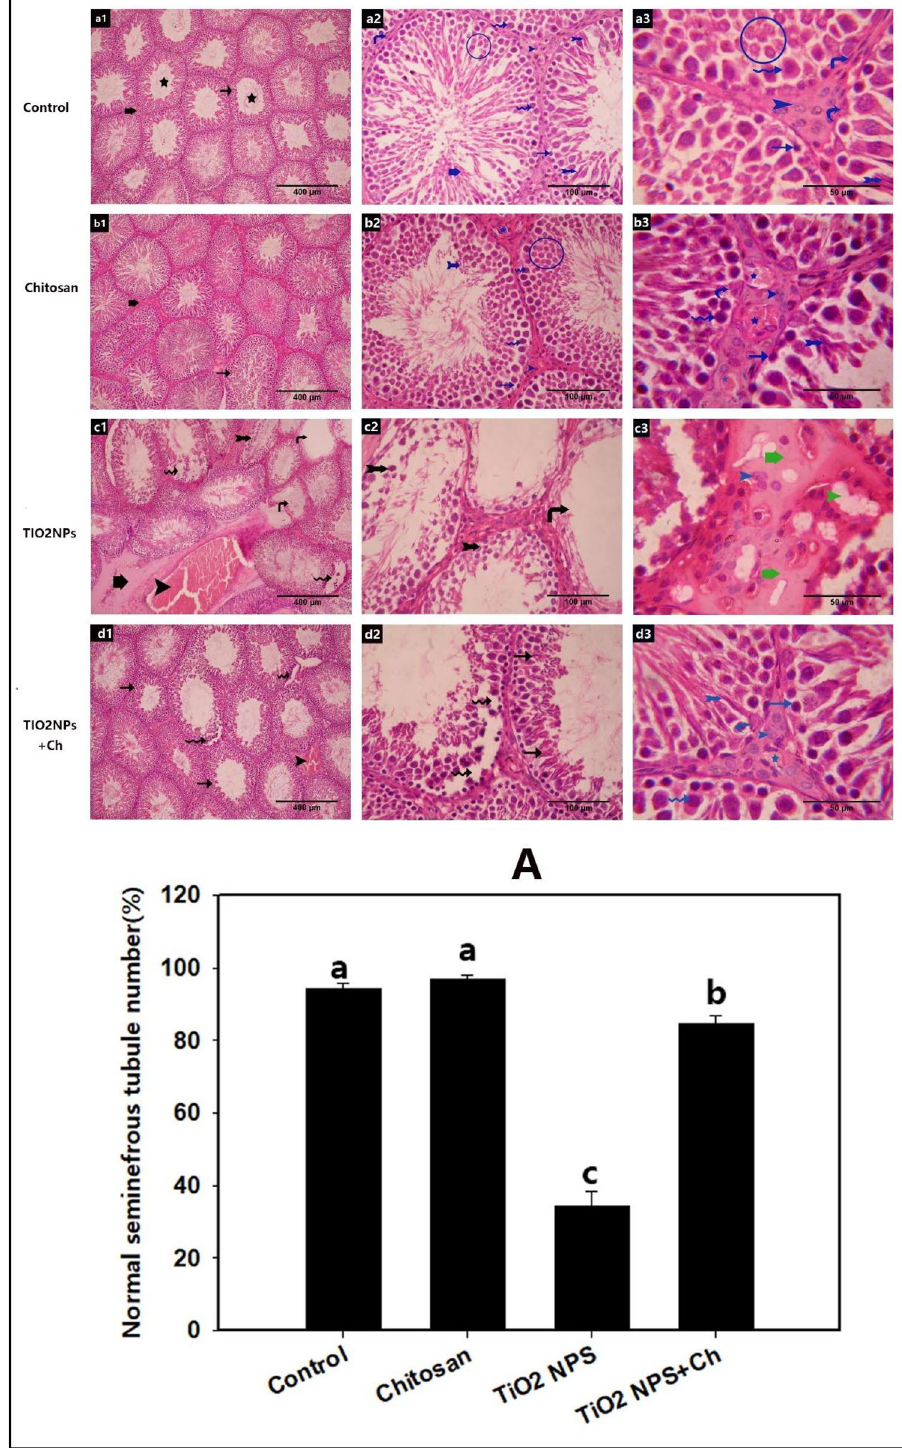
Figure 7. Photomicrograph of a section of rat’s testis stained with H&E in different groups: ( a1 – a3 ) control group, ( b1 – b3 ) chitosan group, ( c1 – c3 ) TIO2NPs and ( d1 – d3 ) TIO2NPs+Ch group, showing seminiferous tubules (black thin arrow), interstitial tissue (black thick arrow), lumen of seminiferous tubules(asterisk), myoepithelial cells (blue vertical arrow), spermatogonia (blue thin arrow), primary spermatocytes (blue corrugated arrow), early spermatid (inside blue circle), mature sperm (tailed blue arrow), hyphae of sperm (thick blue arrow), Leydig cells (blue arrow head), Sertoli cells (curved blue arrow), interstitial blood vessels (blue asterisk), seminiferous tubules with disorganized epithelium (black corrugated arrow), shrinkage seminiferous tubules (black vertical arrow), seminiferous tubules with sloughed and necrotic epithelium (black tailed arrow), congested interstitial blood vessels (white arrow). ( A ): % of normal seminiferous tubules, data are expressed as Mean ± SEM. The different letters (a, b, c) indicate significant difference between experimental